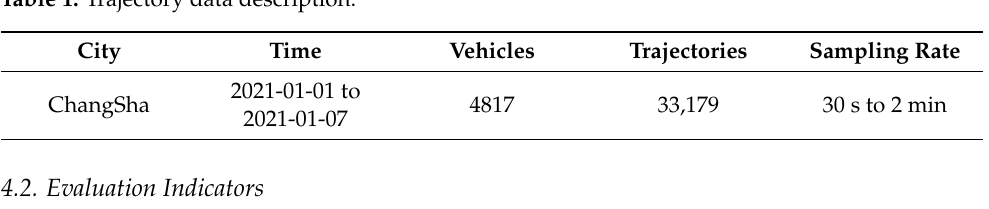
Figure 11. Data introduction of the experiment area: ( a ) trajectory and road network data; ( b ) DOM; and ( c ) images acquired by UAV. Table 1. Trajectory data